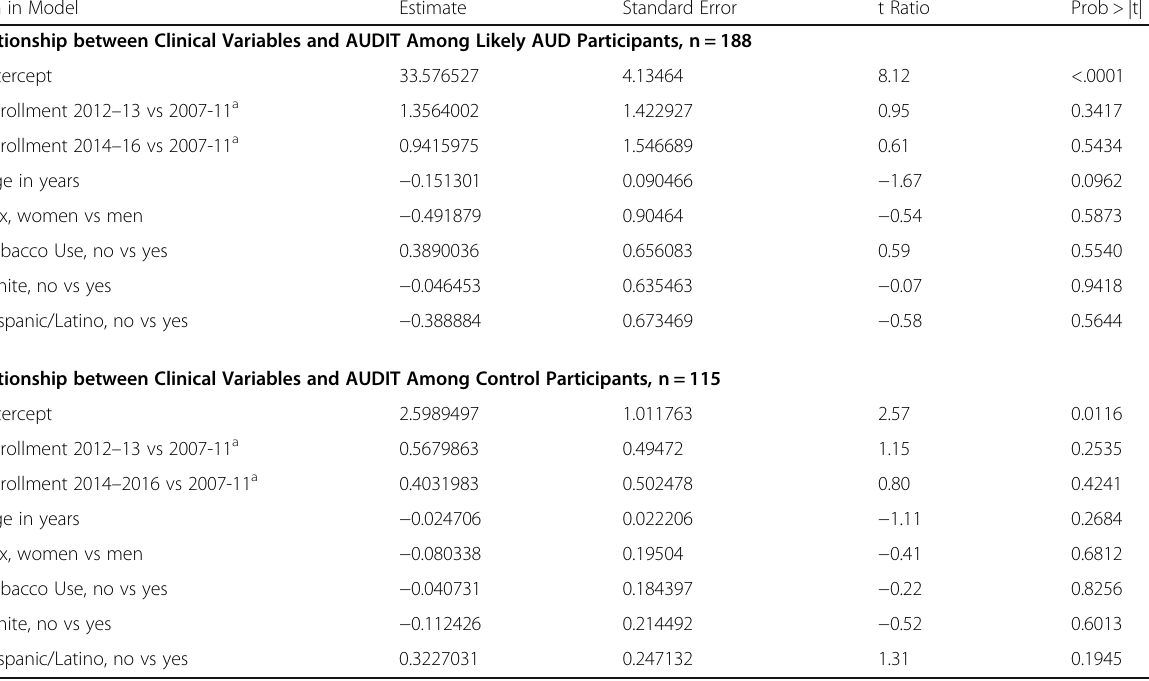
Table 3 Multivariable linear regression analyses to determine relationship between clinical variables and AUDIT scores in likely AUD participants and